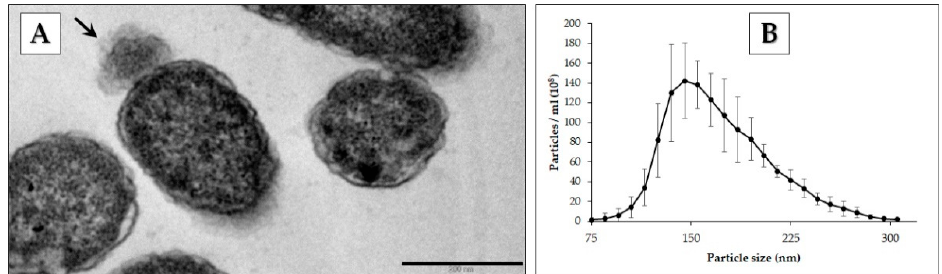
Figure 2. TEM identification of budding vesicles on Pbr1692 cells and isolated OMV size and distri- bution. ( A ) The arrow indicates an OMV budding from a Pbr1692 cell. Bar: 200 nm. ( B ) NTA size distribution and quantification of isolated OMV assessment shows the distribution of Pbr1692 OMVs with an average size of 173.7 ± 1.9 nm isolated in the stationary growth phase.